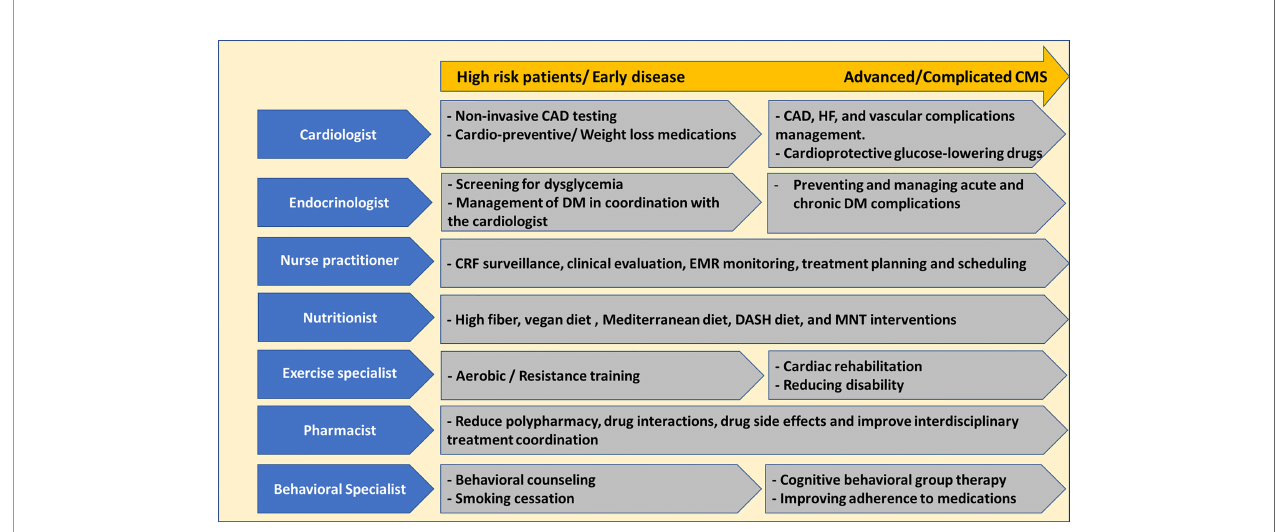
FIGURE 1 | Multimodal services offered at the Cardiometabolic Clinic. CAD, coronary artery disease; CMS, cardiometabolic syndrome; CRF, cardiovascular risk factors; DASH, dietary approach to prevent hypertension; DM, diabetes mellitus; EMR, electronic medical records; MNT, medical nutrition